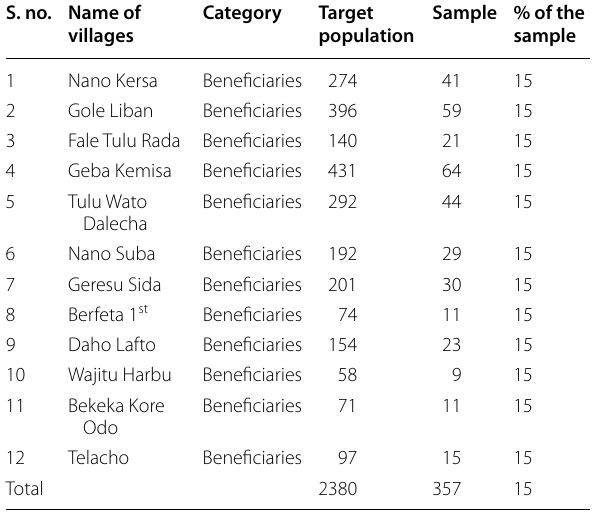
Table 1 Sample villages and sample size. Source : Author’s Survey S. no. Name of